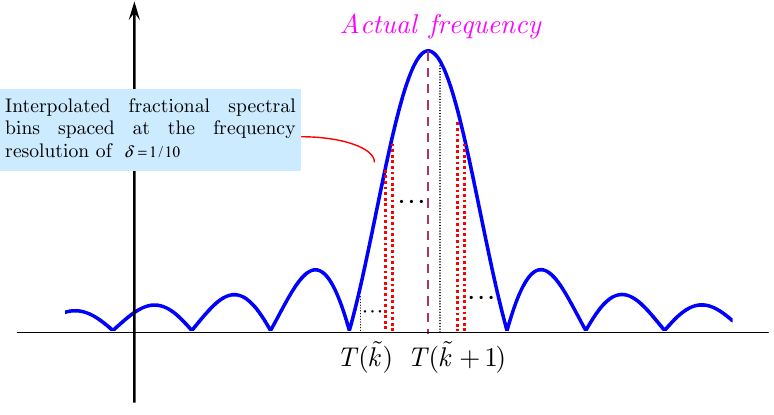
Figure 9. The interpolated spectral bins around an actual harmonic component.